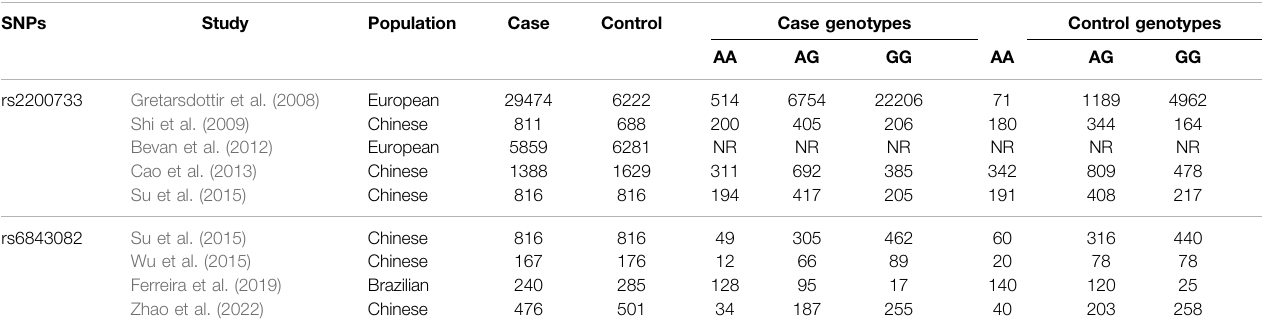
TABLE 1 | Characteristics of studies included in the